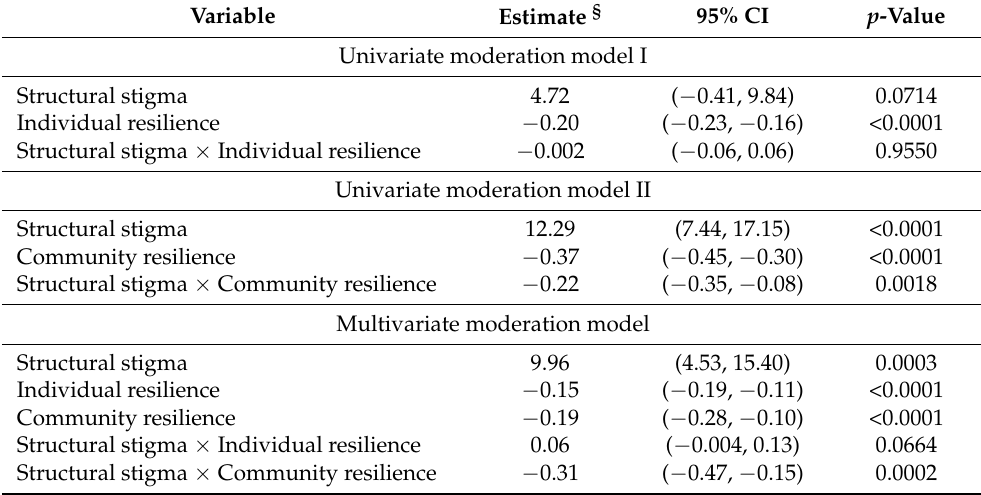
Table 2. Estimated coefficients, confidence intervals, and p -values of structural stigma, individual and community resilience, and suicidal ideation—univariate and multivariate linear regression models. Variable Estimate § 95% CI p